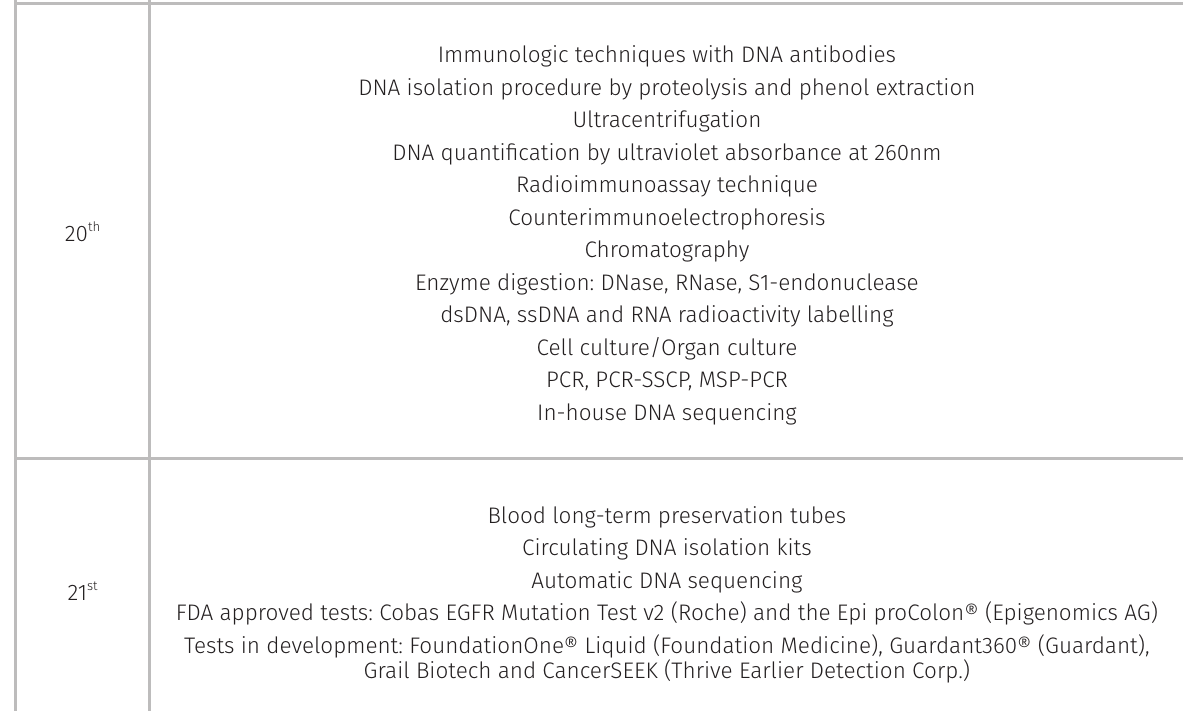
Table II. Technology evolution to detect and isolate circulating DNA. Century Methods Immunologic techniques with DNA antibodies DNA isolation procedure by proteolysis and phenol extraction Ultracentrifugation DNA quantification by ultraviolet absorbance at 260nm